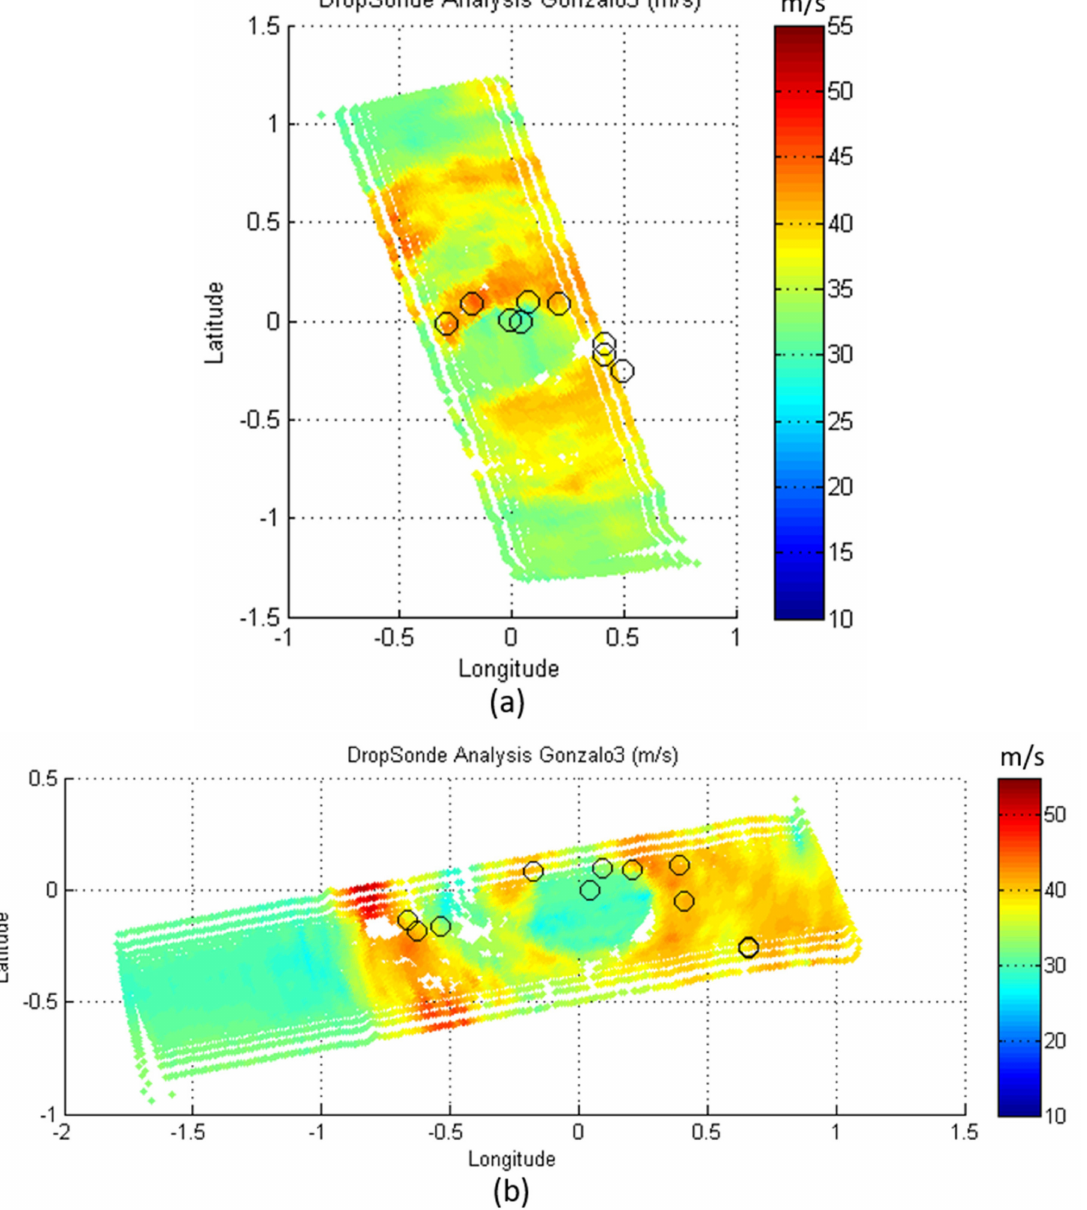
Figure 17. Dropsonde WS measurement locations (black circles) in storm-relative coordinates relative to the HIRAD WS measurement swath within ± 1 h of HIRAD measurement time. Panel ( a ) is HIRAD Leg 4, and panel ( b ) is Leg 6 for Hurricane